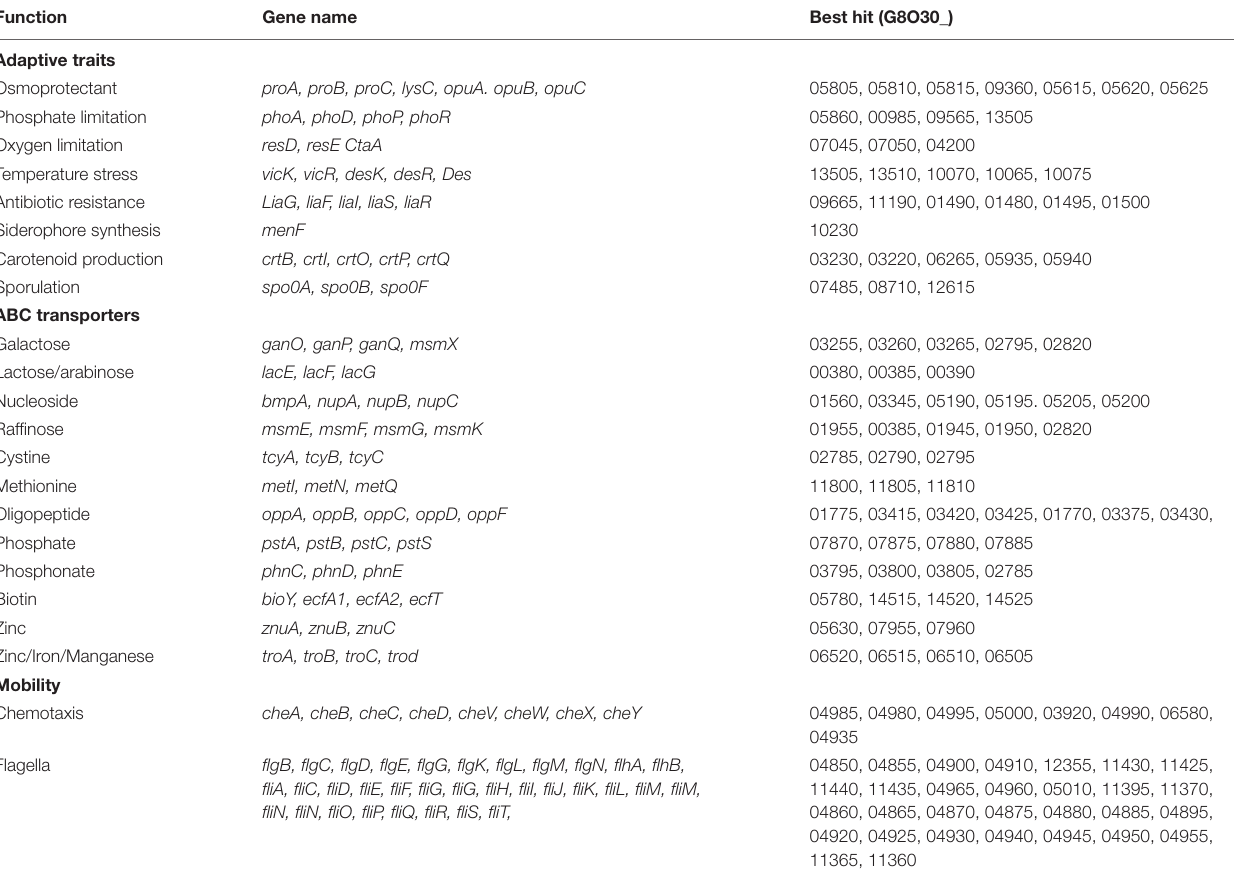
TABLE 3 | Genes associated with adaptive traits, transports of metabolites and mobility in Mangrovibacillus cuniculi R1DC41 T .